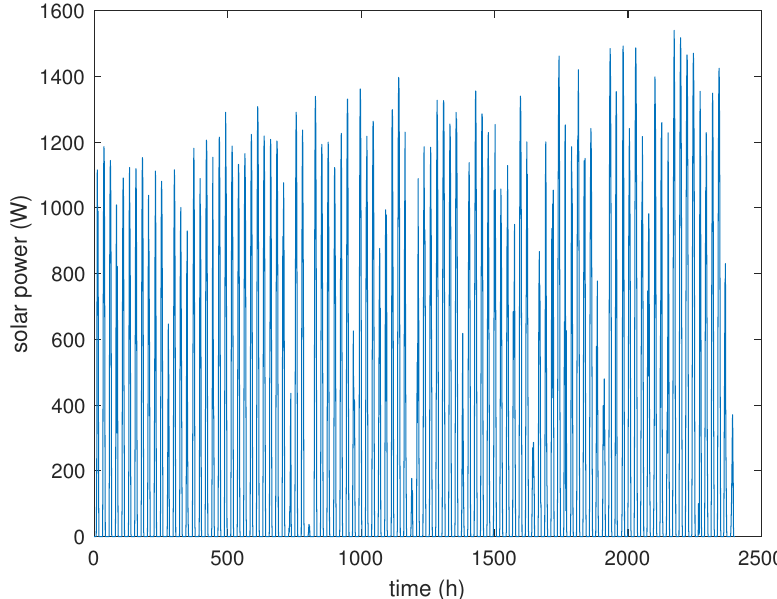
Figure 7. Solar power datasets for one hundred days.